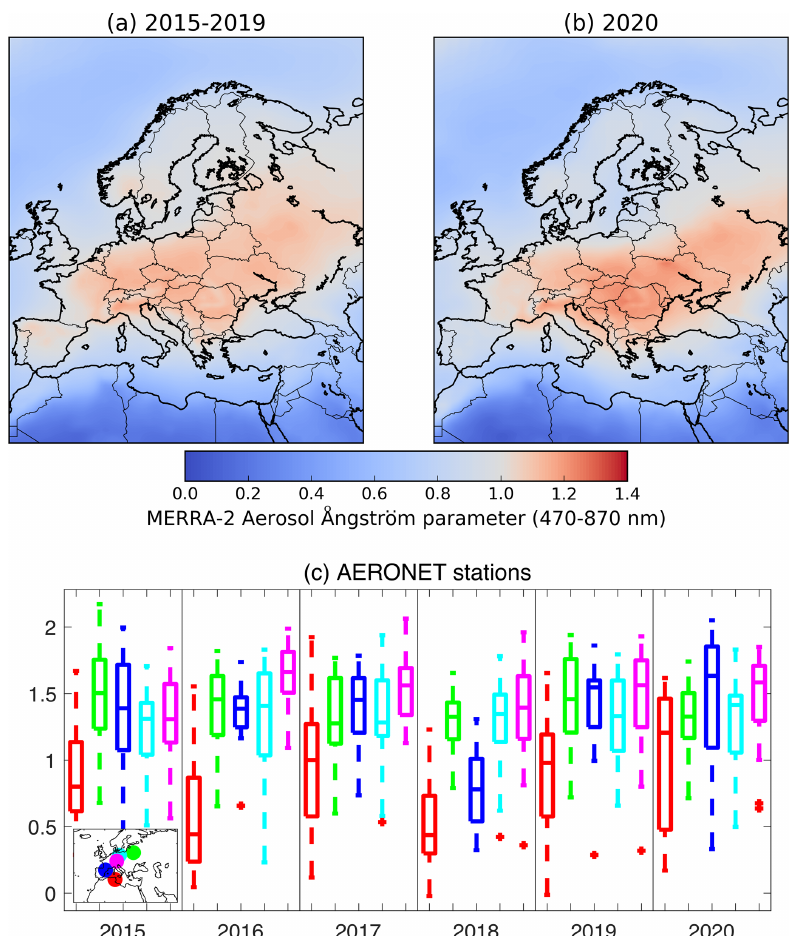
Figure 8. (a) Average total aerosol Ångström parameter (470–870nm) over Europe (mid-March to April) in the 5 previous years (2015– 2019) and (b) in 2020 (lockdown). (c) AERONET Absorption AE in Ben Salem (9.91 ◦ E, 35.55 ◦ N; in red), Minsk (27.60 ◦ E, 53.92 ◦ N; green), Montsec (0.73 ◦ E, 42.05 ◦ N; blue), MetObs Lindenberg (14.12 ◦ E, 52.21 ◦ N; magenta) and Munich University (11.57 ◦ E, 48.15 ◦